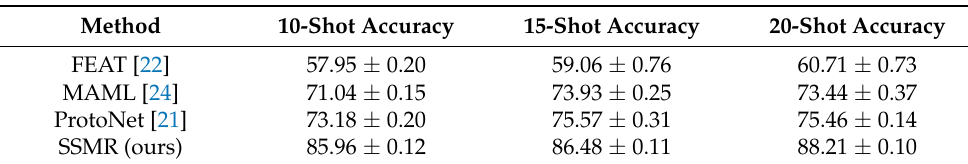
Table 4. Few-shot classification accuracy (%) results for 10 shots on a five-way task, 15 shots on a five-way task, and 20 shots on a five-way task. Ninety-five percent confidence intervals are provided for all results.